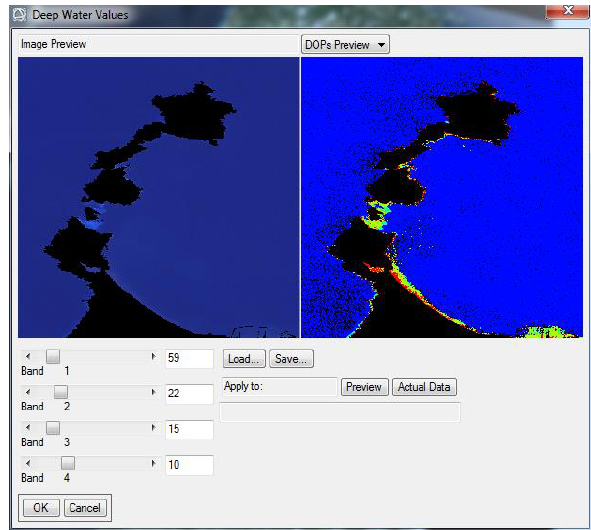
Figure 11. Adjusting the maximum “deep water” values with the sliders